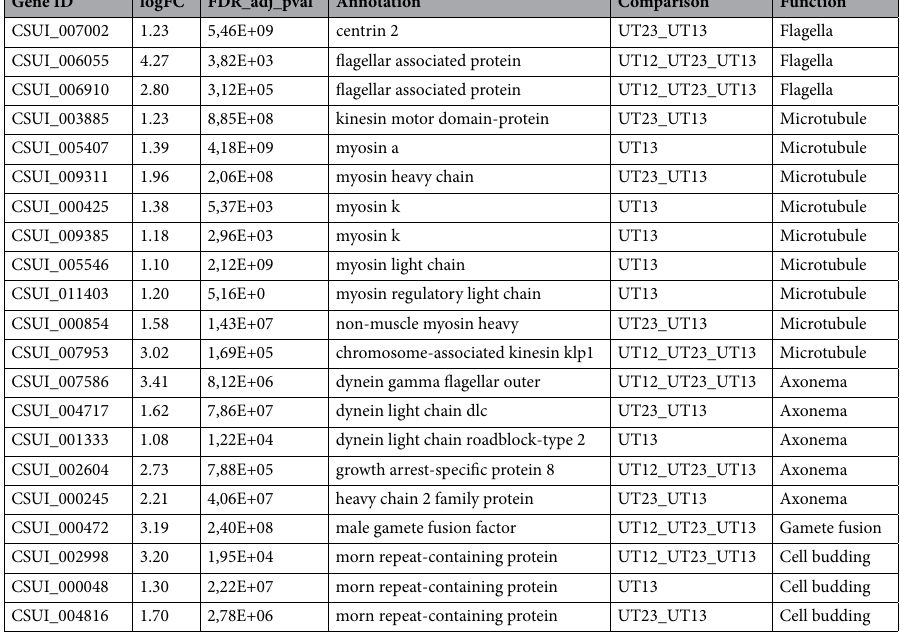
Table 2. Upregulated transcripts coding for proteins with known or putative roles in microgamete biology. They are listed along with their transcript abundance (LogFC), annotation, comparison (upregulated transcripts (UT) in early sexual stages(2) compared to merozoites(1), UT12, late sexual stages (3) compared to merozoites (1), UT13, and late sexual stages (3) compared to early sexual stages(2), UT23) and biological